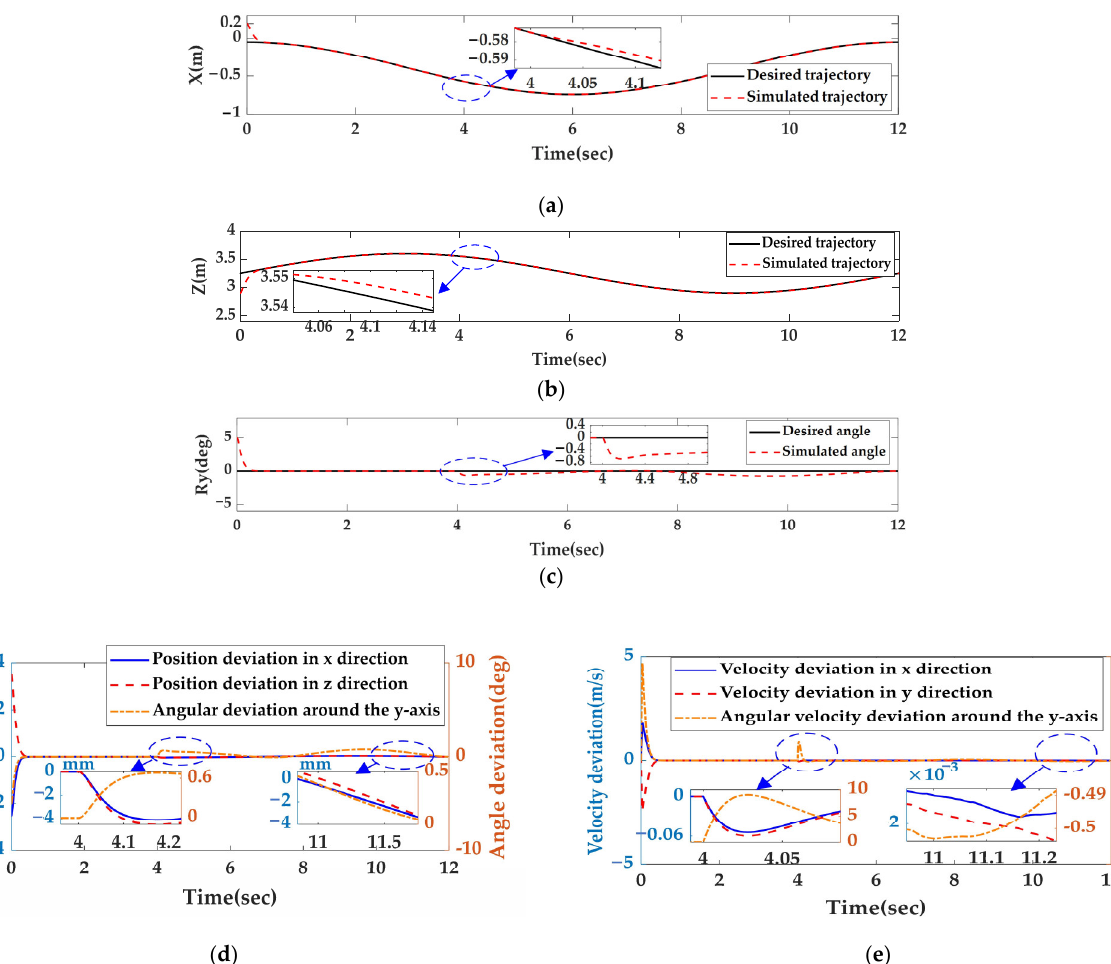
Figure 9. The simulation results without wave excitation: ( a ) x -direction trajectory tracking; ( b ) z -direction trajectory tracking; ( c ) y -direction angle tracking; ( d ) trajectory tracking error; ( e ) velocity tracking error.